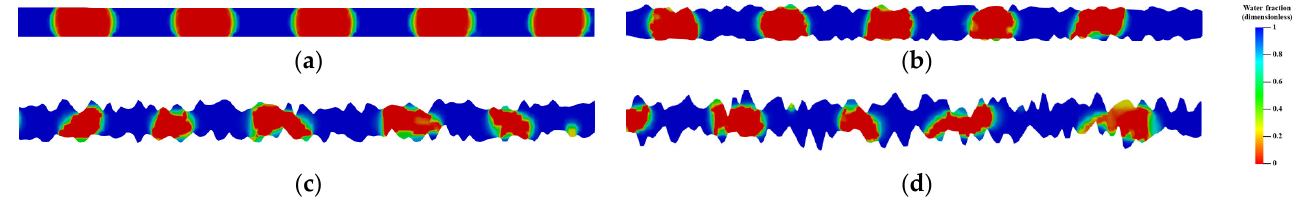
Figure 7. Snapshots of the gas and water distribution in single-fracture models. ( a ) Roughness = 0; ( b ) roughness = 0.4; ( c ) roughness = 0.7; and ( d ) roughness = 1.3.